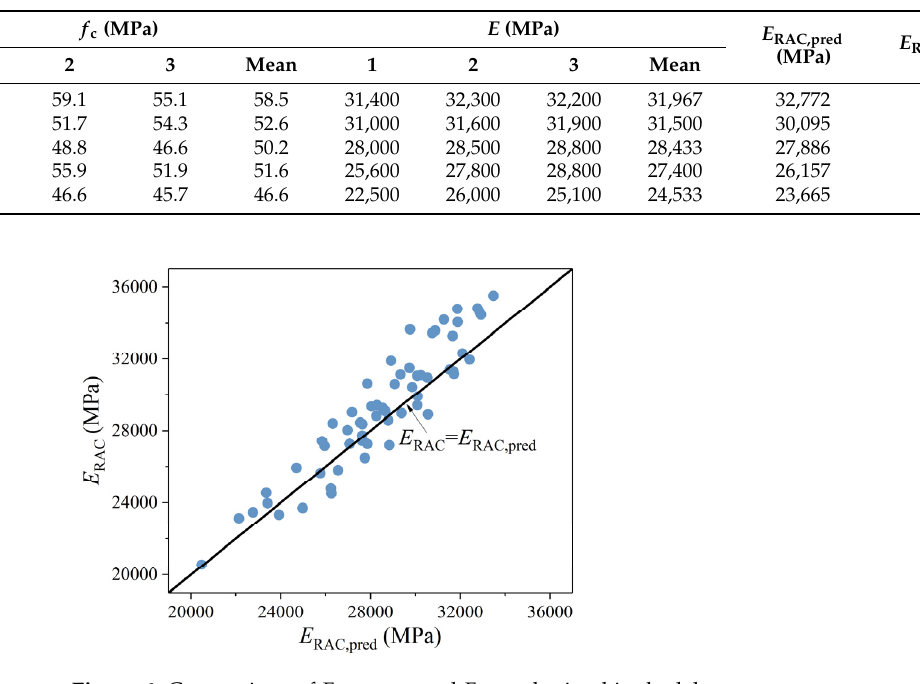
Figure 6. Comparison of E RAC,pred and E RAC obtained in the Laboratory tests.